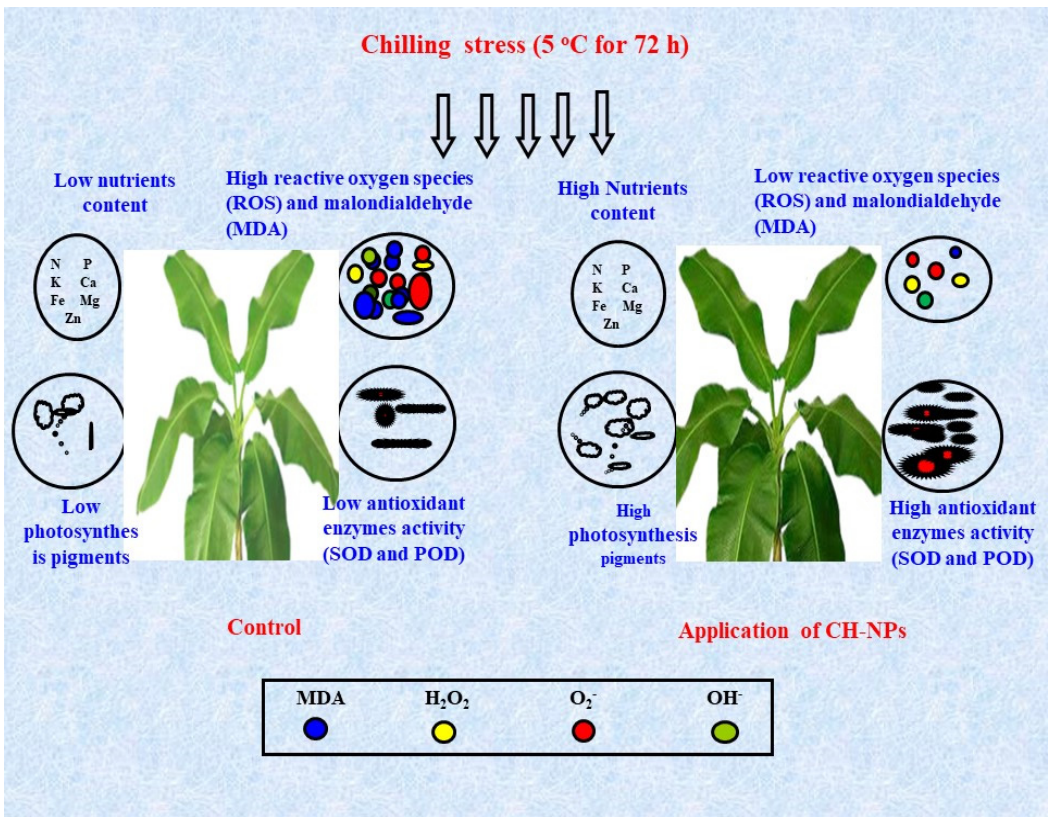
Figure 4. Schematic diagram exploring the roles of chitosan nanoparticles (CH-NPs) in enhancing the cold stress resistance of banana plants.